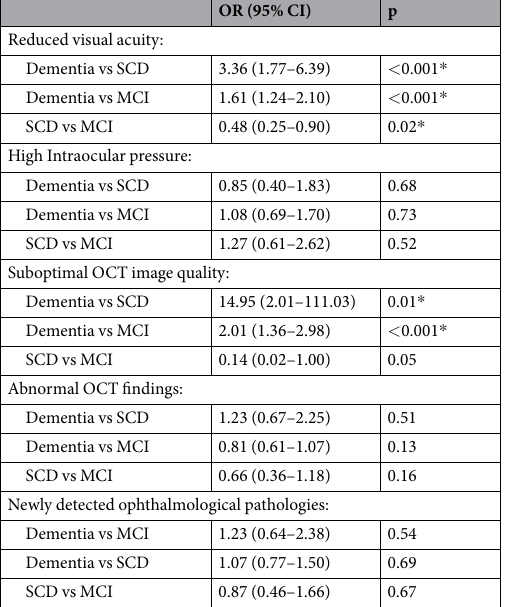
Table 5. Diagnostic group differences in ophthalmological exam and OCT findings. A Multinomial Logistic Regression model including age, gender and years of education as co-variates was used to analyse group differences in ophthalmological exam and OCT scan findings. For each comparison, the first listed group acted as the reference one. Statistical significance was set-up at p < 0.05. CI = confidence interval; MCI = mild cognitive impairment; OCT = optical coherence tomography; OR = odds ratio; SCD = subjective cognitive